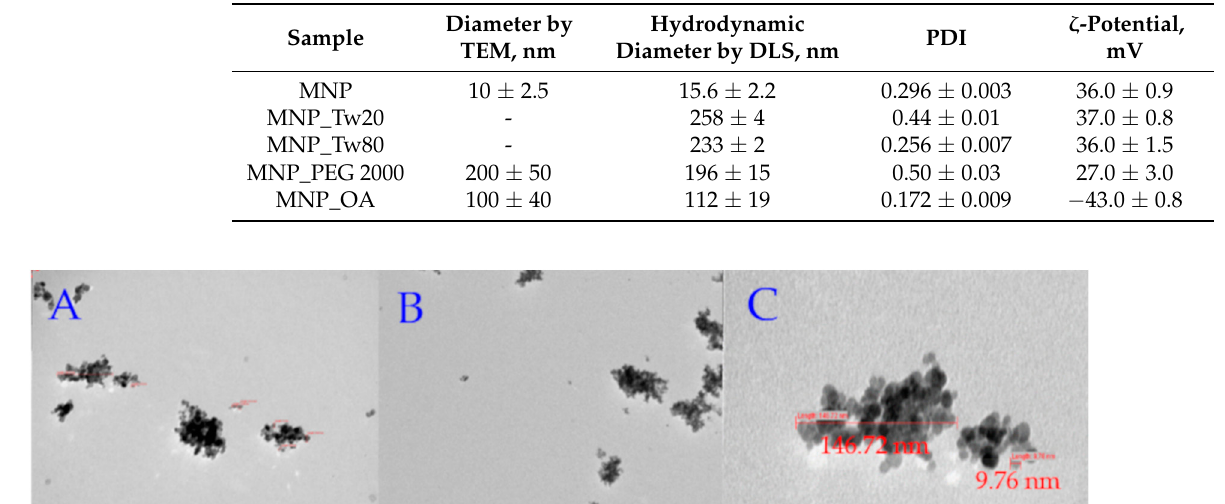
Table 1. Hydrodynamic diameter, polydispersity index (PDI), and ζ -potential of synthesized MNPs in water (pH 5.5).